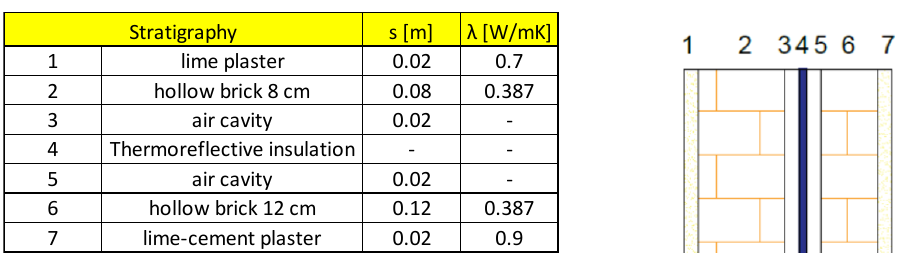
Figure A4. Wall type 2: transmittance check for the three main Italian climatic zones. In blue are the heat-reflective materials which respect all the limits.